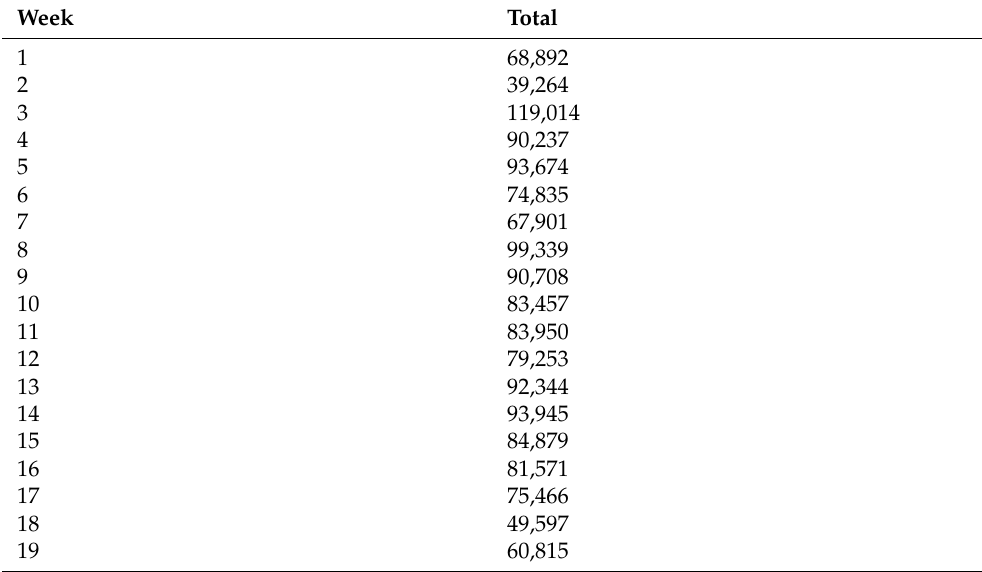
Table 2. Household Pulse Survey responses per week.